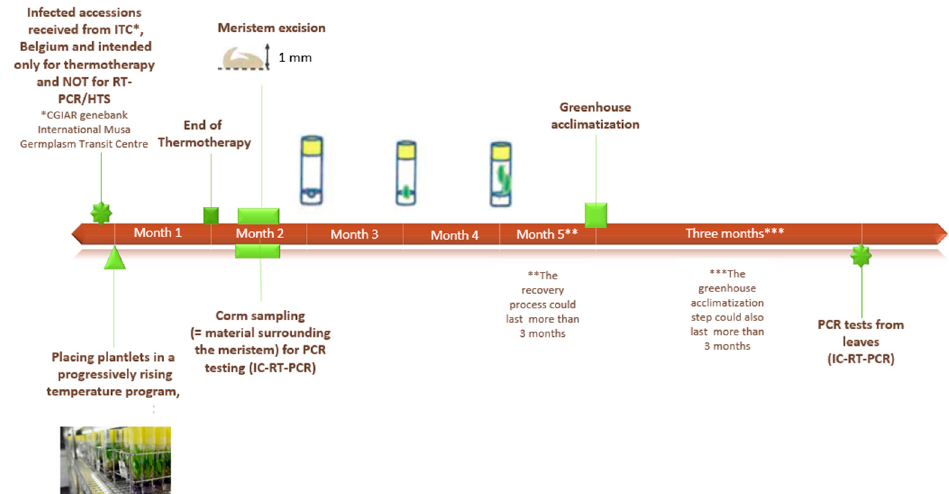
Figure 1. Flowchart of the sanitation process used in this work, describing the different steps involved in the work carried out and the tests performed throughout the experiment.